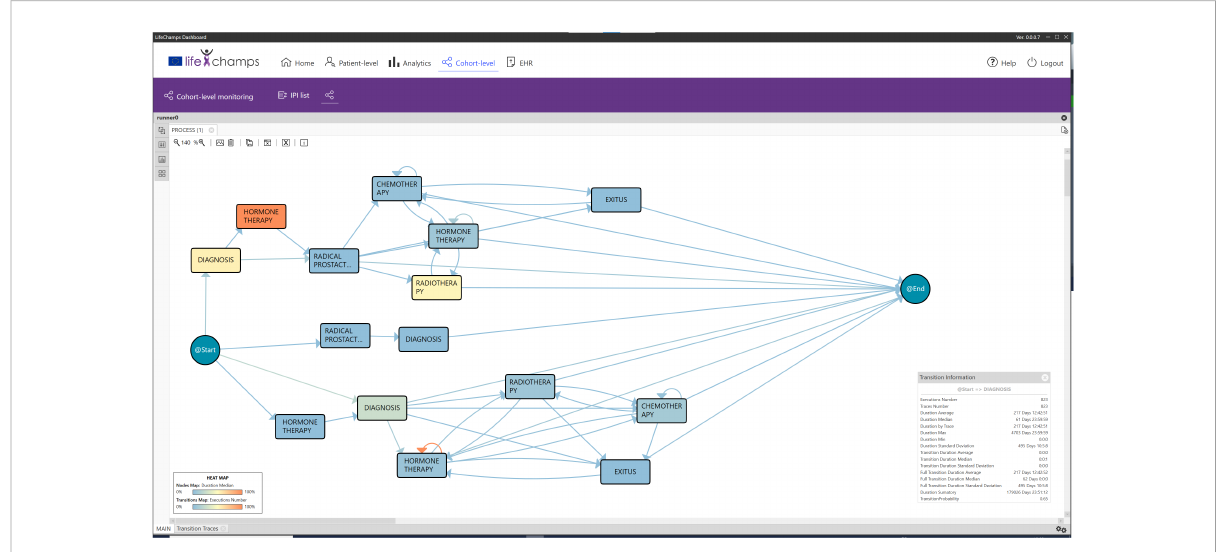
FIGURE 4 IPI: main process. IPI representing the care episodes of 1,267 patients with prostate cancer diagnoses. More orange color in nodes, as opposed to blue, represents higher time in median in that stage, while more orange color in transition means larger number of cases in that transition as speci fi ed in the heat map legend (also included in the fi